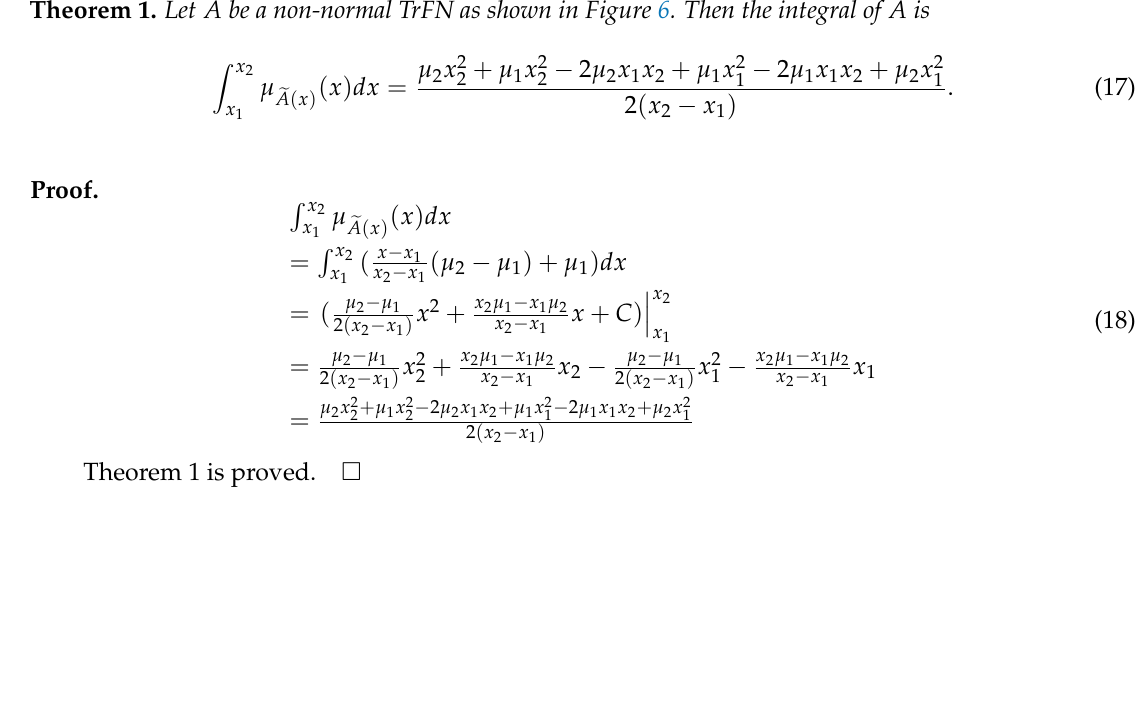
Figure 5. The PCFI result as a union of non-normal trapezoidal fuzzy numbers (TrFNs).